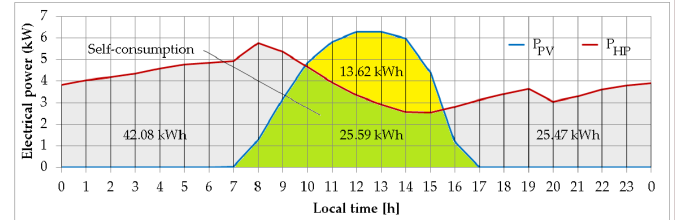
Figure 14. Simulated hourly the electrical power consumption of the geothermal heat pump (P HP ) and of the electrical power production (P PV ) of the photovoltaic platform (18 January